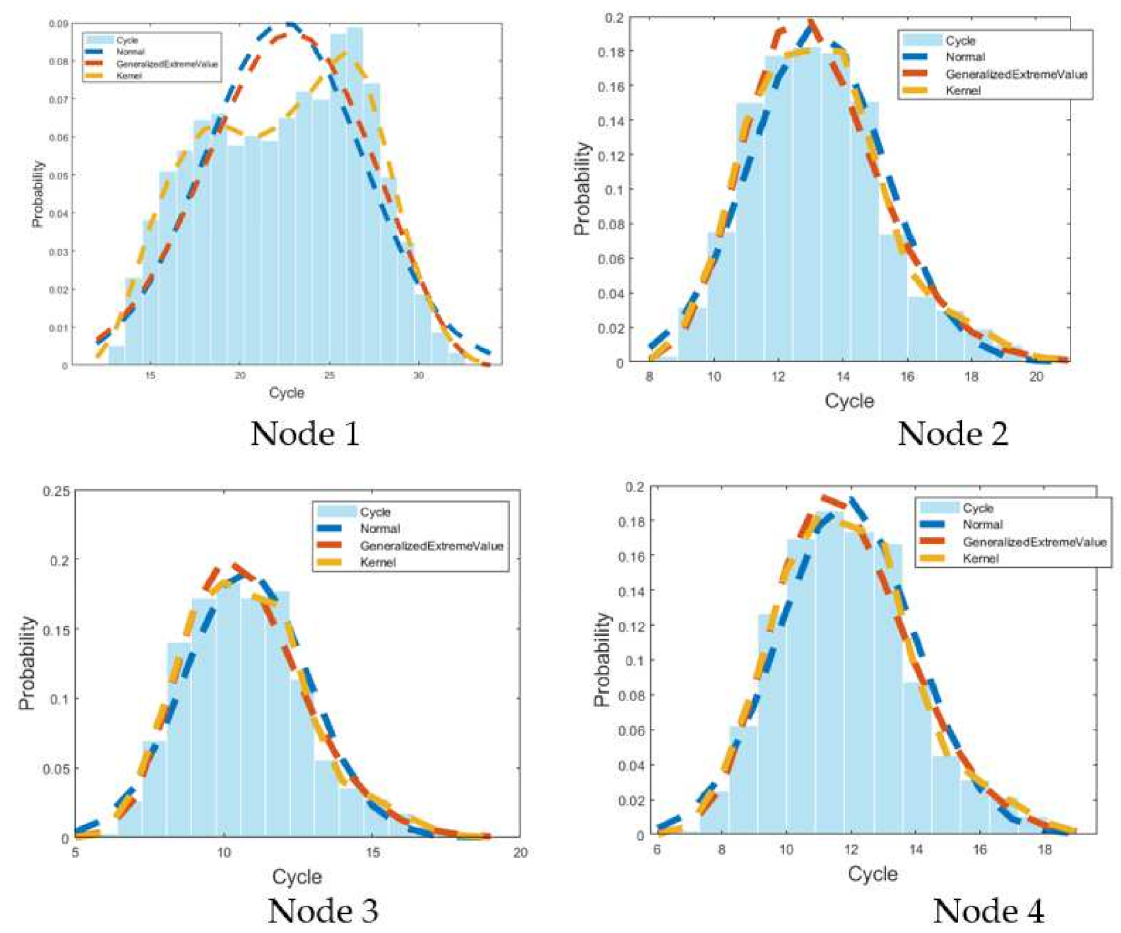
Figure 8. Probability distribution statistics of lifespan.